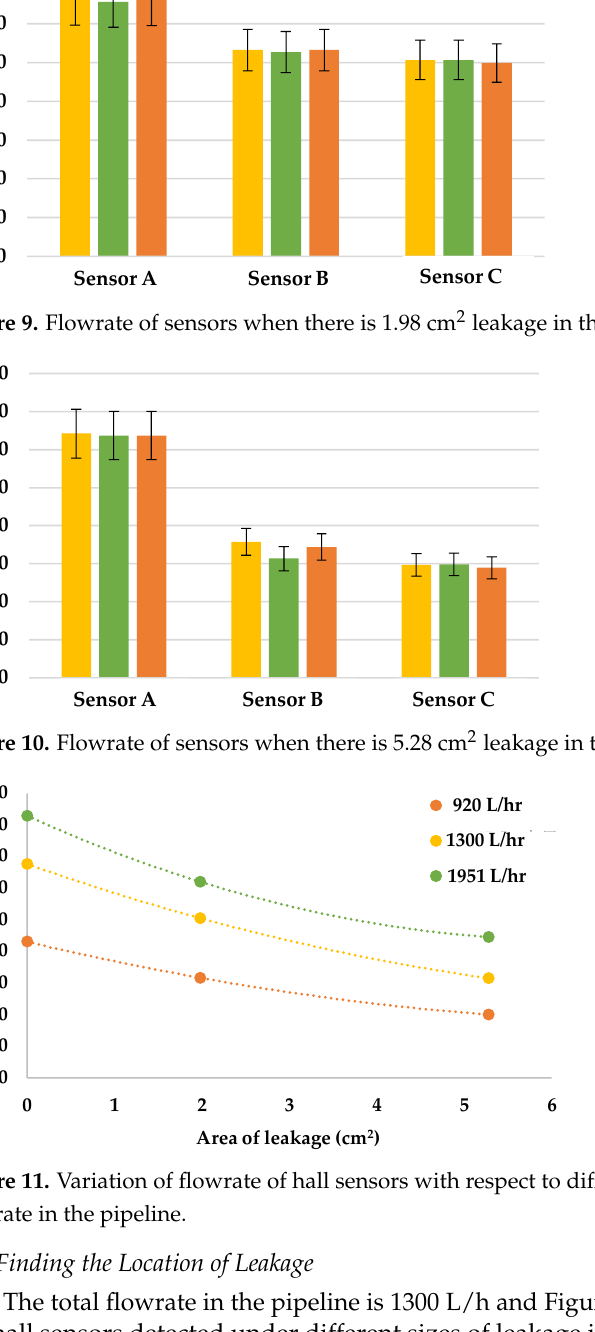
Figure 8. Flowrate of sensors when there is no leakage in the pipeline.